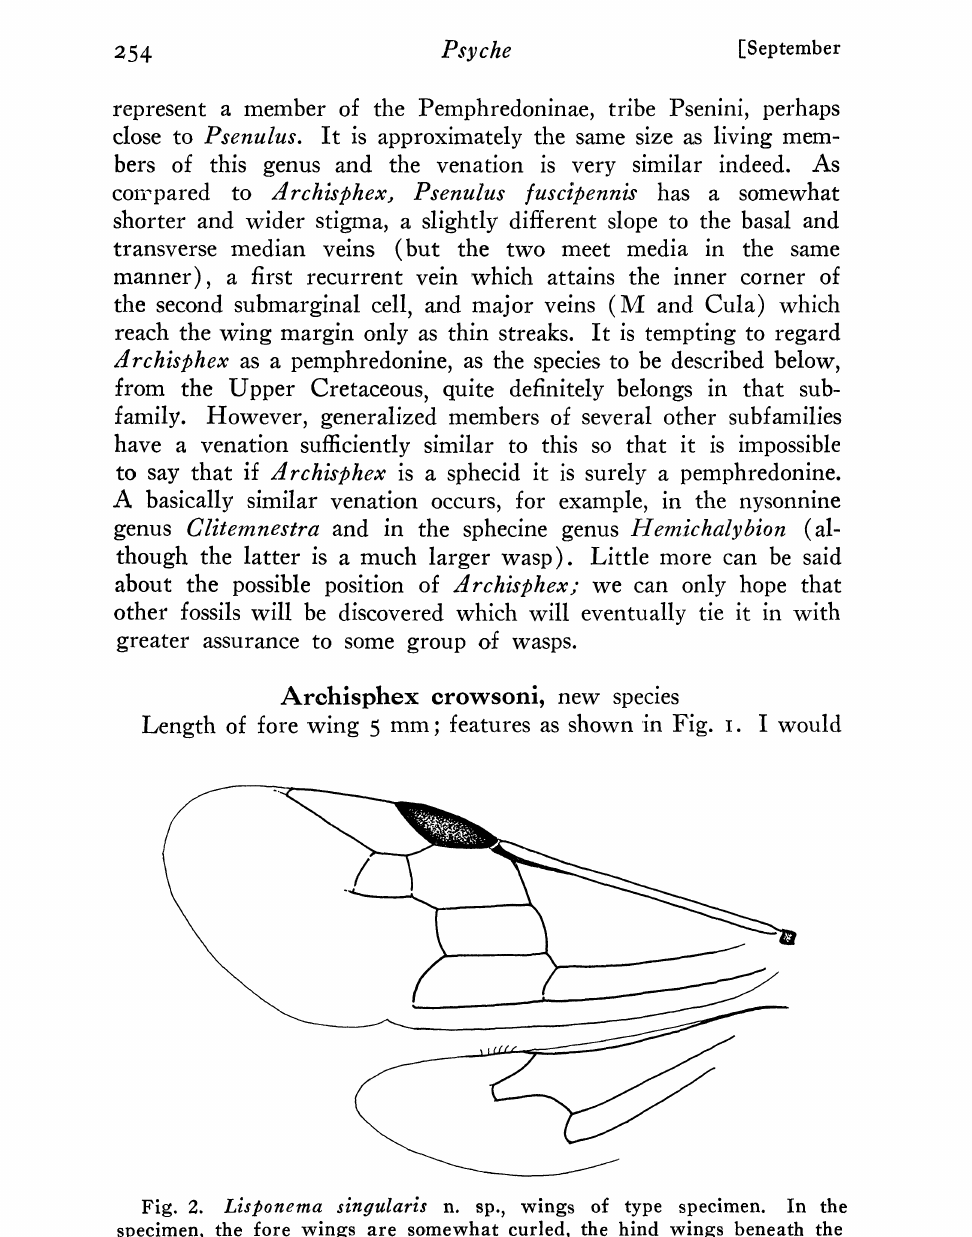
Fig. 2. Lisponema singularis n. sp., wings of type specimen. In the specimen, the fore wings are so.mewhat curled, the hind wings beneath the fore wings; they are shown here as if drawn apart and